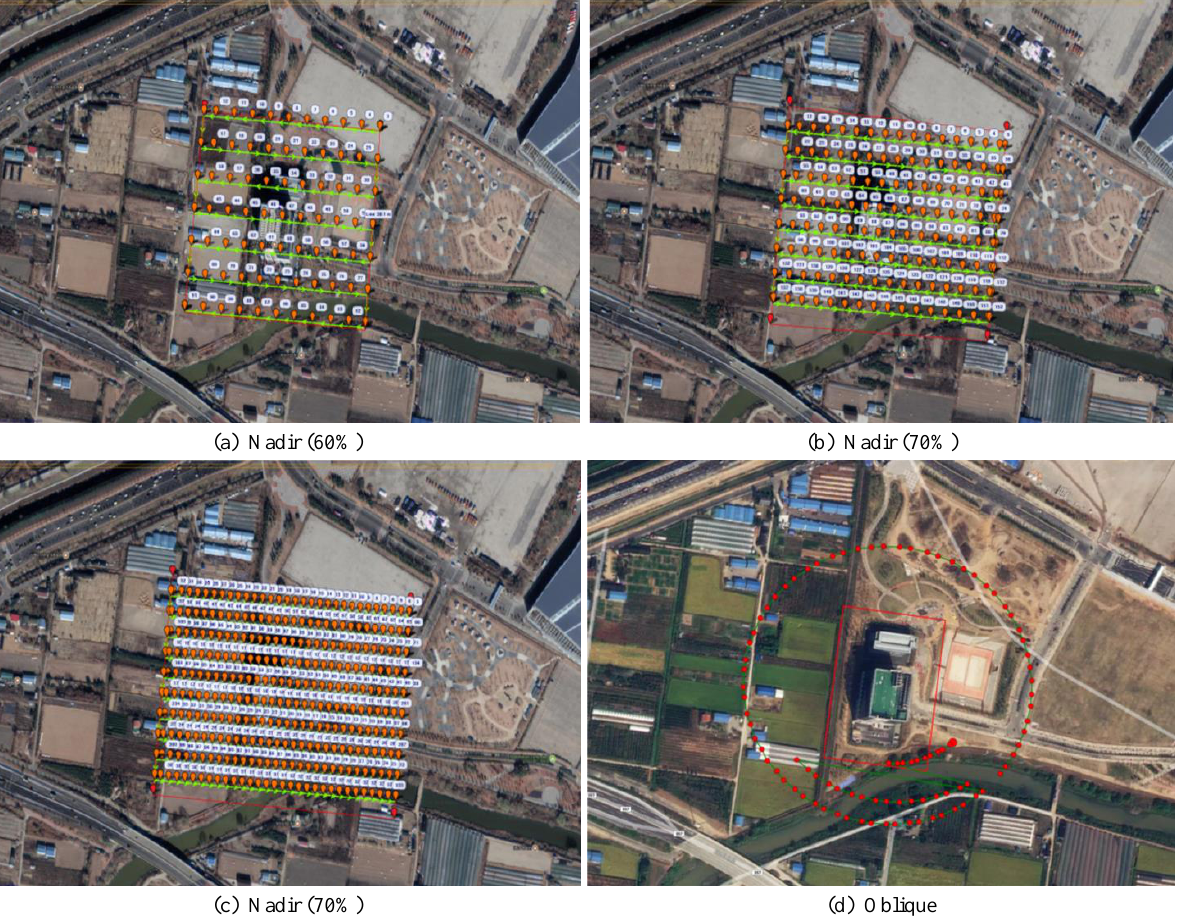
Figure 1. Test flight method and